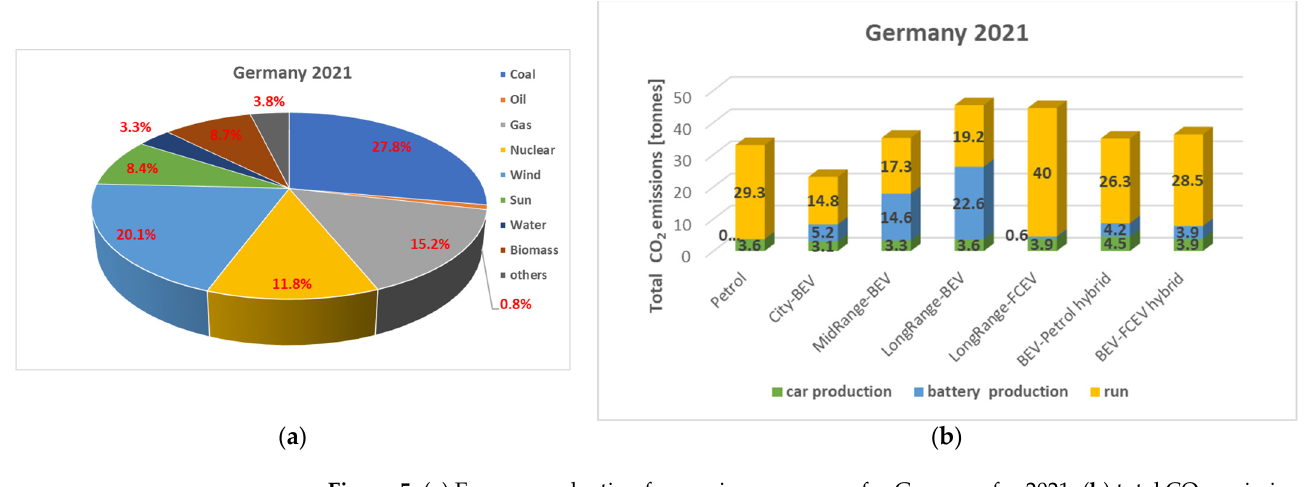
Figure 4. ( a ) Energy production from primary sources for Europe for 2021. ( b ) total CO 2 emissions for 2021 for Europe for different types of cars, including car and battery production, as well as running of the vehicle considering different sources for energy production.